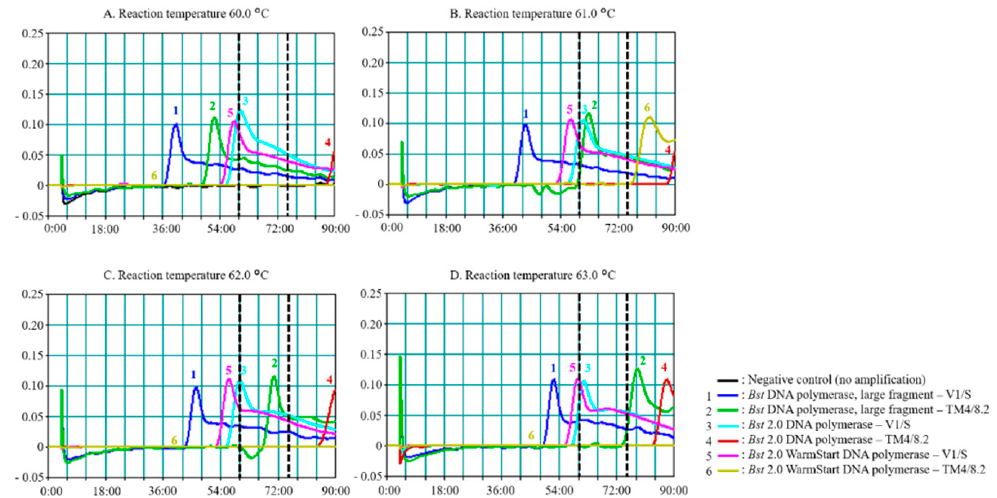
Figure 1. Effects of temperature and enzyme choice on SNP-loop-mediated isothermal amplification ( Pf SNP-LAMP) performance to detect mutant single nucleotide polymorphism (SNP) in the Pfdhfr-ts gene. Reactions were performed at ( A ) 60.0 °C, ( B ) 61.0 °C, ( C ) 62.0 °C, and ( D ) 63.0 °C. A total of 20 ng of template DNA was used for each reaction. Lines 1 and 2 were reactions using Bst DNA polymerase large fragment on pUC18- Pfdhfr -V1 / S (mutant SNP) and pUC18- Pfdhfr -TM4 / 8.2 (wild-type SNP), respectively. Lines 3 and 4 were reactions using Bst 2.0 DNA polymerase on V1 / S and TM4 / 8.2, respectively. Lines 5 and 6 were reactions using Bst 2.0 WarmStart DNA polymerase on V1 / S and TM4 / 8.2, respectively. The 60-min and 75-min markers were shown with dashed lines. Signals were read by Loopamp Realtime Turbidimeter for up to 90 min. Similar results were obtained in three independent experiments.